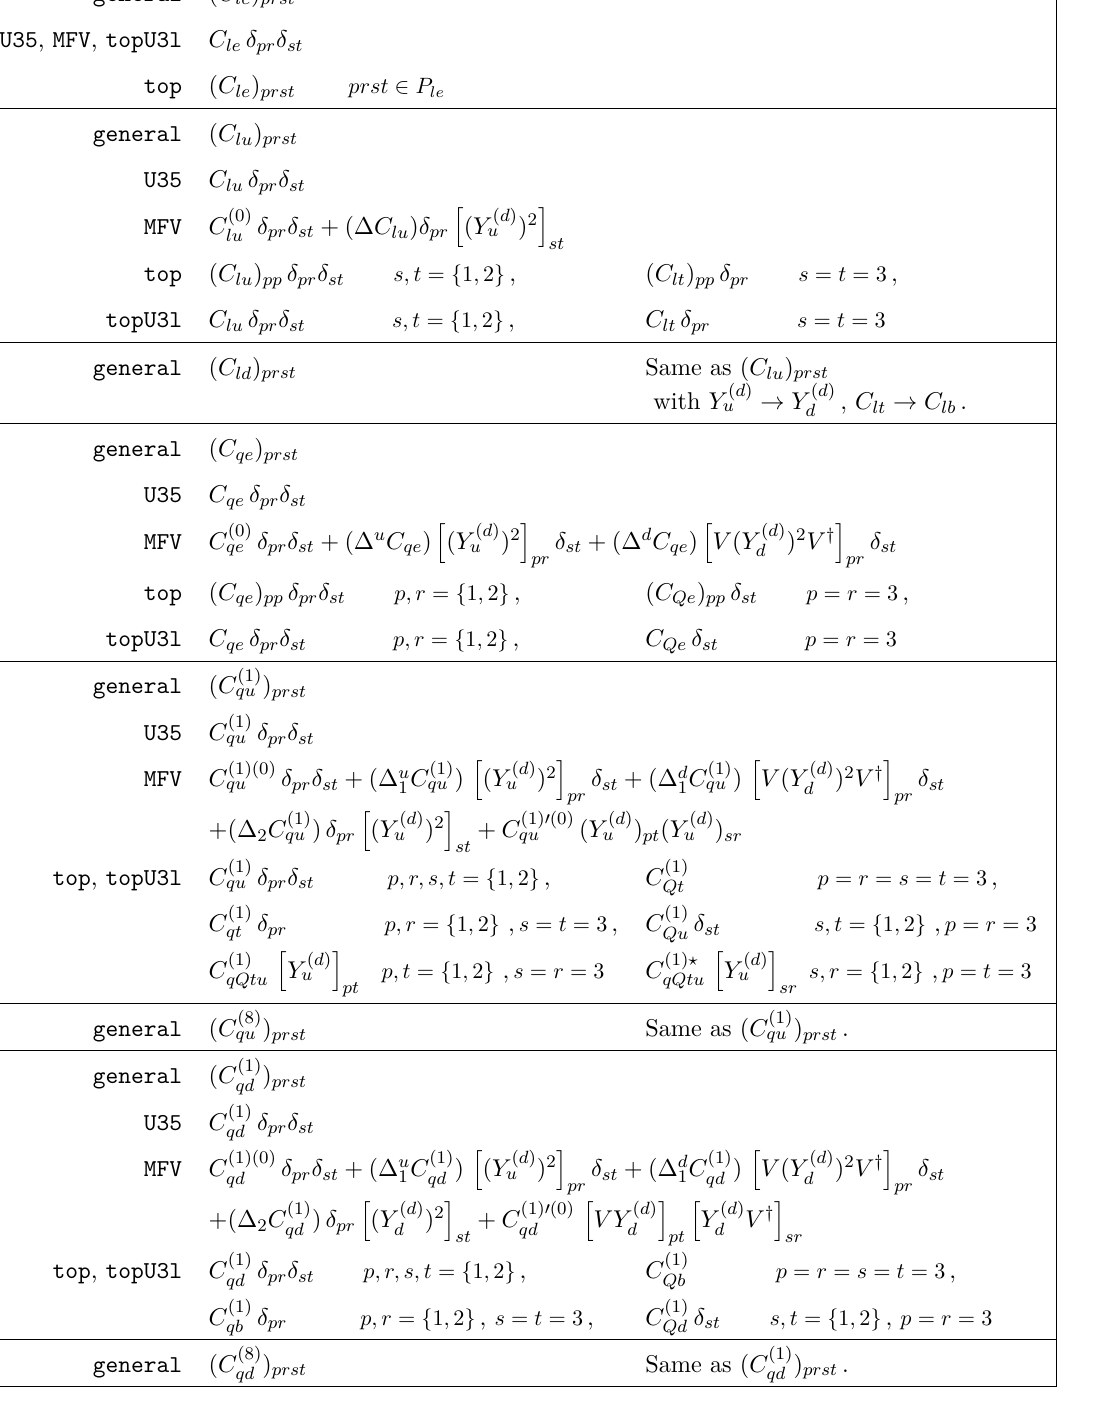
Table 14 . Conversion table among the 5 flavor assumptions considered, for the operators in L (8 c ) The set P is defined in eq. le